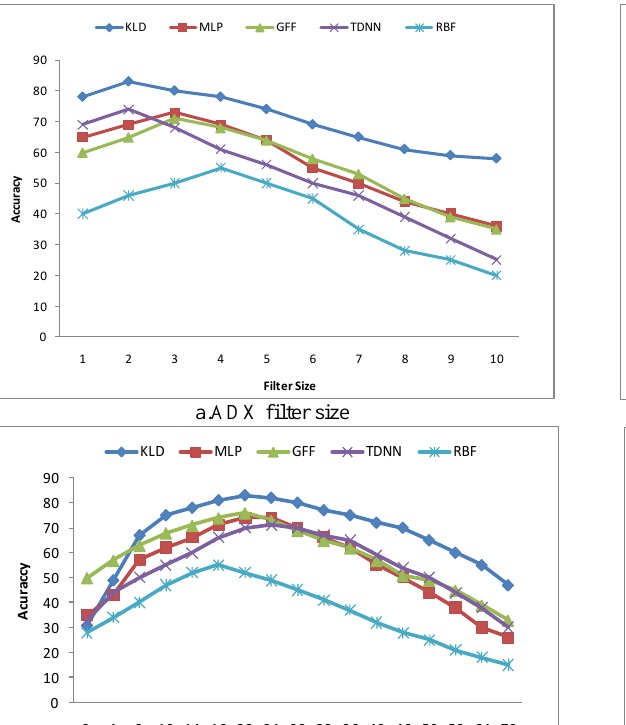
Fig. 7. Sensitivity analysis for data set parameters using ELEC data